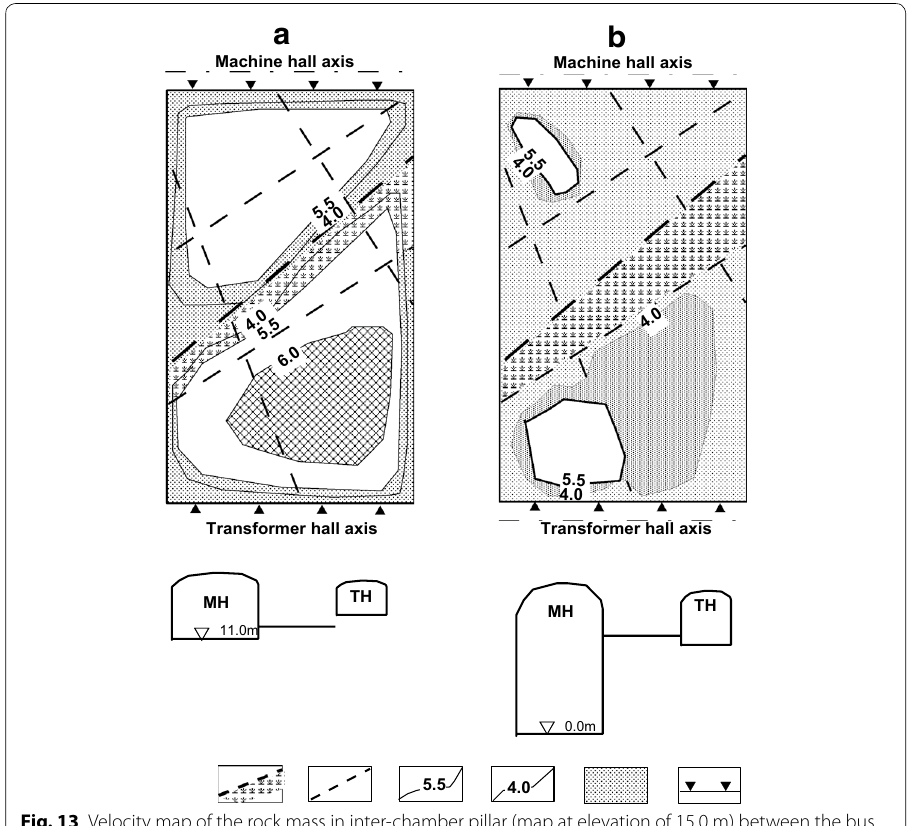
Fig. 13 Velocity map of the rock mass in inter-chamber pillar (map at elevation of 15.0 m) between the bus duct galleries GT-1 and GT-2 at different construction stages: a MH bottom is at elevation 11.0 m; b one at elevation of 0.0 m. 1-V order crack with gabbro-diabase dike; 2-VI order crack; 3-velocity isoline Vp (boundary of loosed zone; 4-one, 4.0 km/s (boundary of the fractured zone); 5-zone of plastic